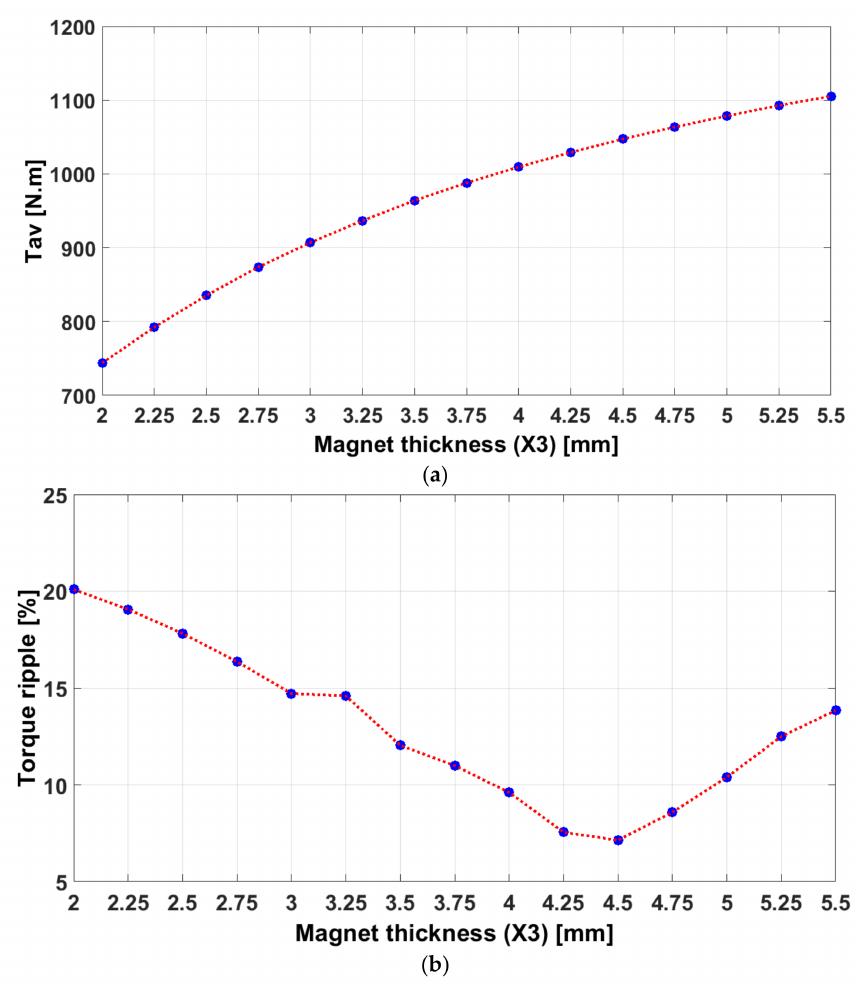
Figure 6. Impact of the side magnet thickness variation on: ( a ) the average torque; ( b ) the torque